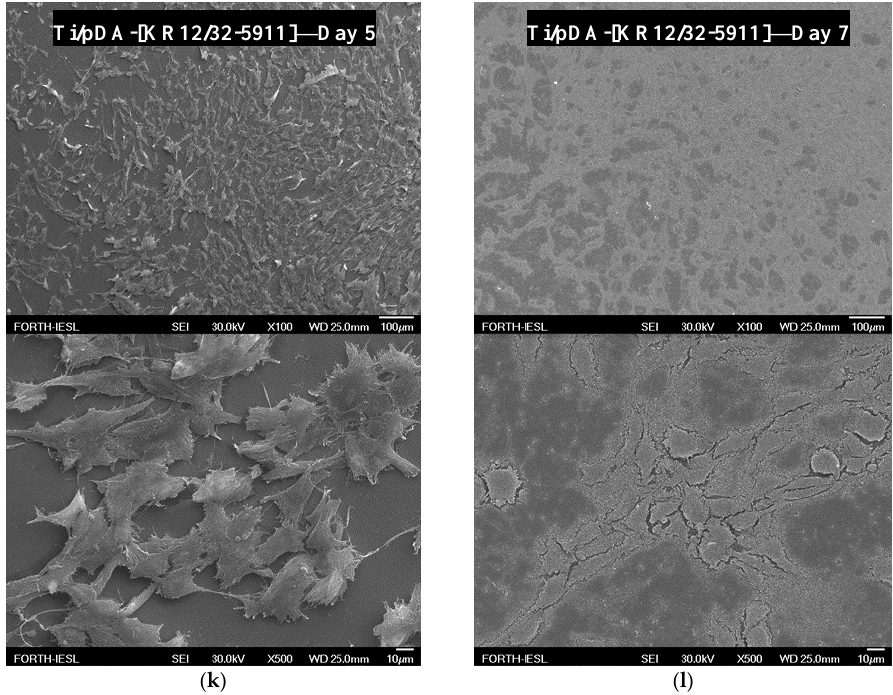
Figure 8. SEM micrographs showing the growth of the seeded human osteosarcoma cells (HOS) on day 5 and 7 for ( a , b ) Ti6Al4V, ( c , d ) Ti6Al4V/pDA, ( e , f ) Ti6Al4V/pDA-KR12, ( g , h ) Ti6Al4V/pDA-KR12/32, ( i , j ) Ti6Al4V/pDA-KR12/5911, and ( k , l ) Ti6Al4V/pDA-KR12/32-5911 at 100× and 500× magnification, respectively.